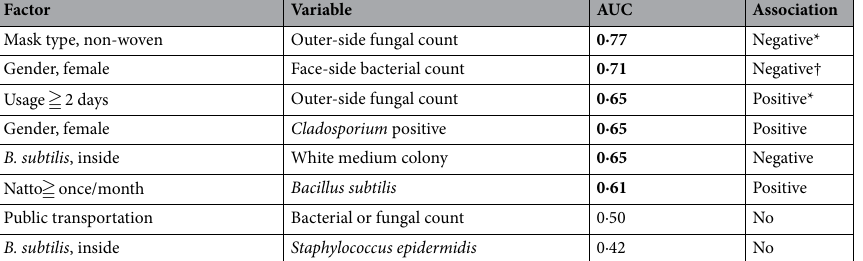
Table 2. Receiver operating characteristic (ROC) analysis. Boldface shows AUC higher than 0.6 AUC: 0.5–0.6, unsatisfactory; 0.6–0.7, satisfactory; 0.7–0.8, good; 0.8–0.9, very good; 0.9–1, excellent. *, † Associations were consistent with statistical differences shown in *, Figs. 2; †,